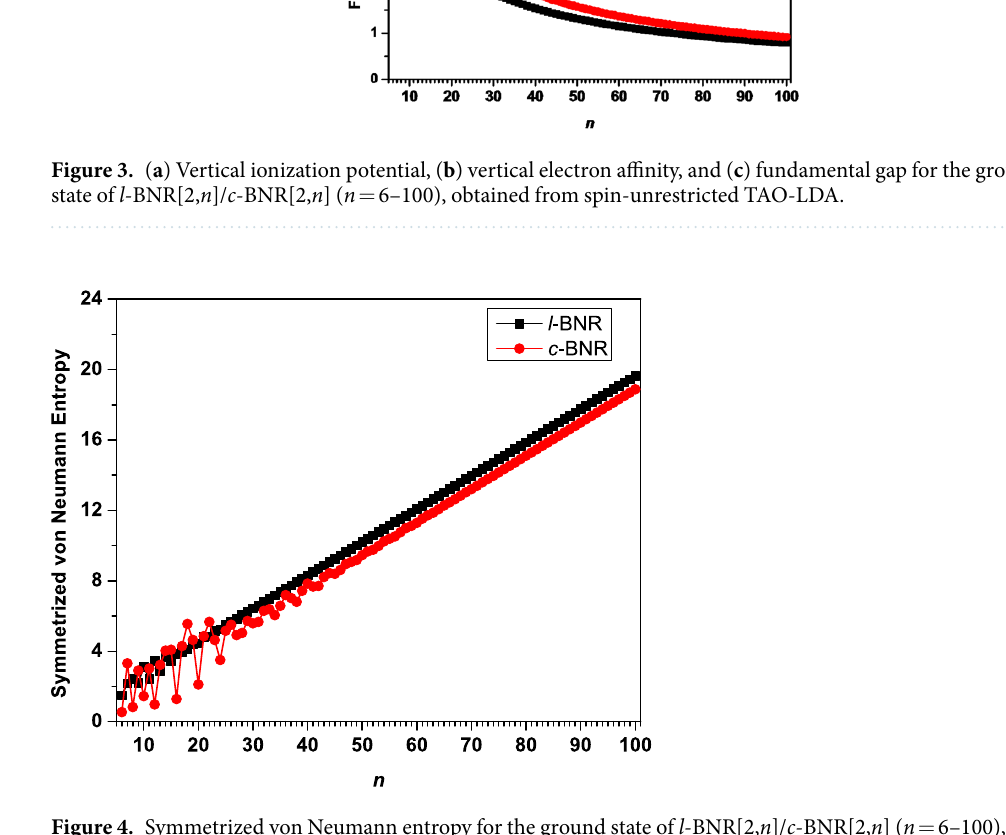
Figure 4. Symmetrized von Neumann entropy for the ground state of l -BNR[2, n ]/ c -BNR[2, n ] ( n = 6–100), obtained from spin-unrestricted